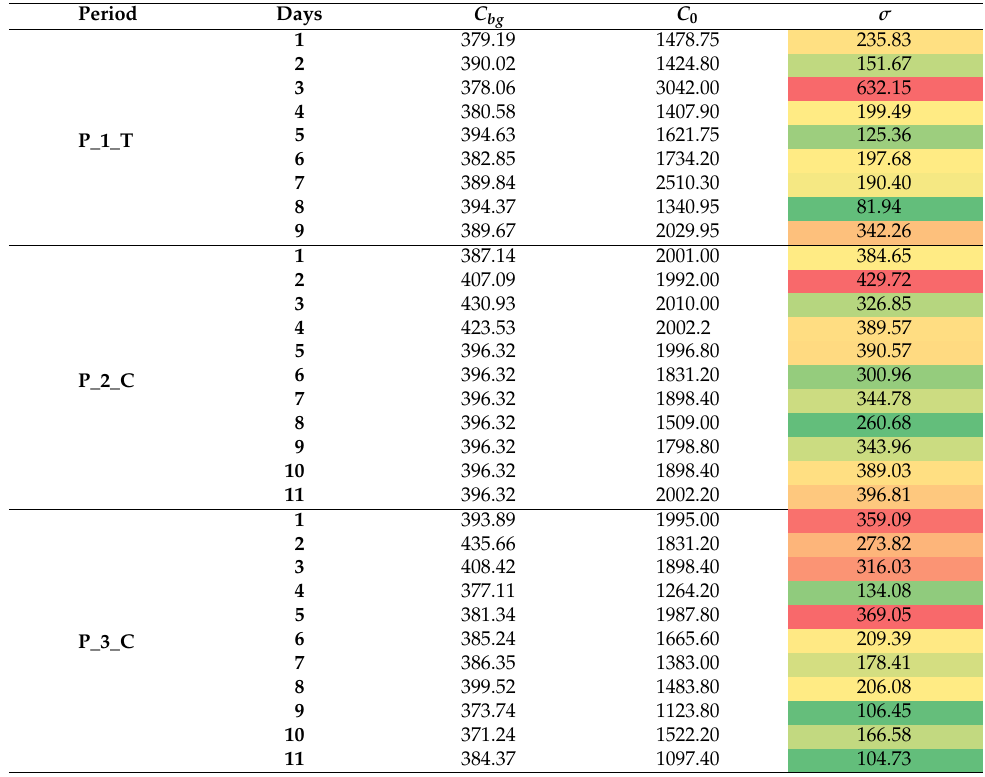
Table 3. CO 2 daily measurements at t = 0 in ppm. C bg means the daily average of the measured outdoor CO 2 concentration in the air; C o is the average of the observed indoor CO 2 concentration in the space, and σ is the standard deviation of the day in ppm. Red is the highest value and green the lowest one.